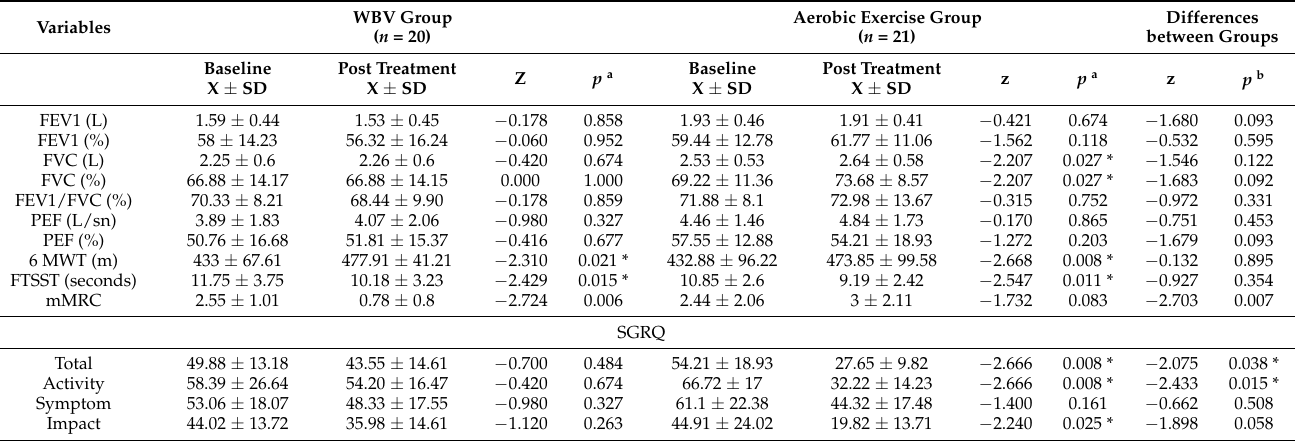
Table 2. The effect of treatment on functional exercise capacity, dyspnea, respiratory functions, and disease